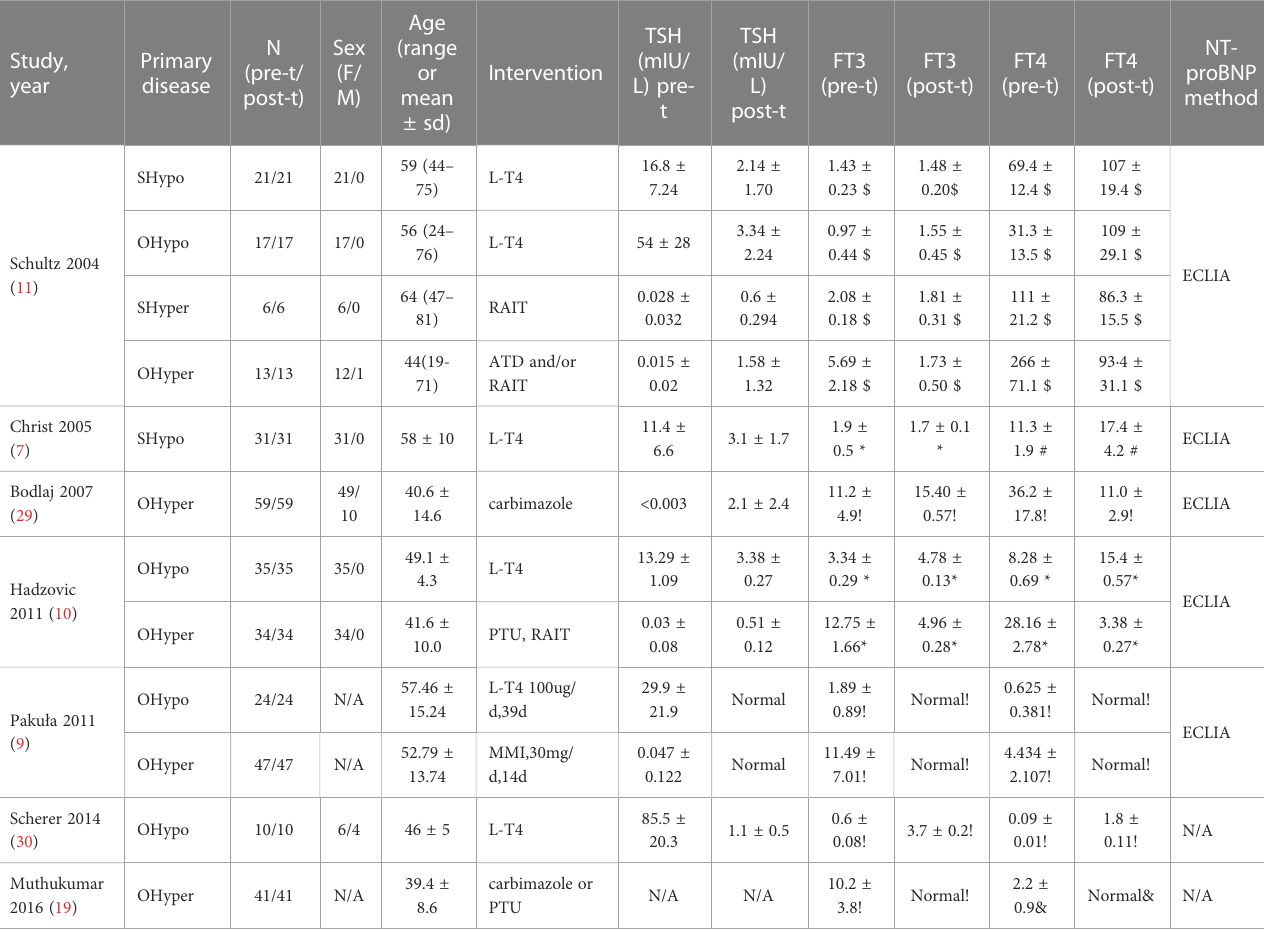
TABLE 2 The characteristics of the included self-controlled trials that discussed NT-proBNP levels at pre-to-post treatment in